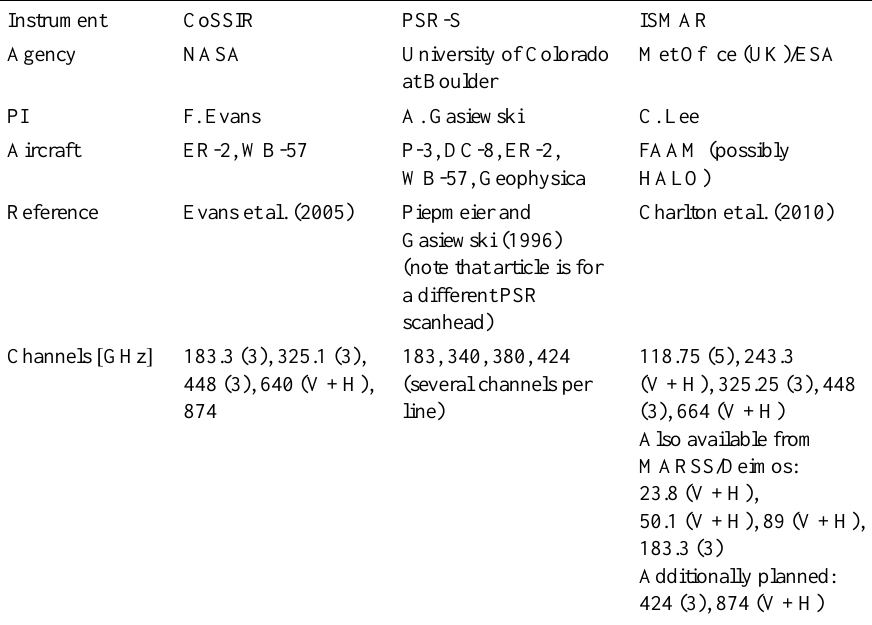
Table 9. A summary of airborne submillimeter-wave radiometers of interest to the CloudIce science community. ISMAR is still under development, the other two instruments are already available.